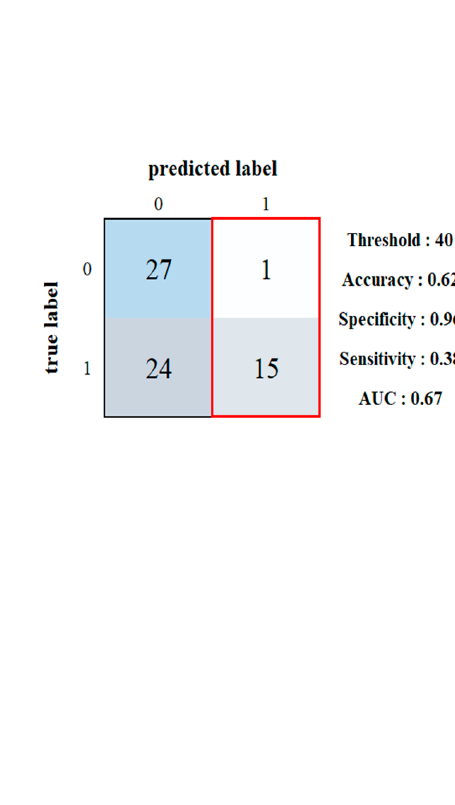
threshold score, the mean accuracy, specificity, sensitivity, and AUC of LDA were 62.68%, 0.96, 0.38, and 0.67, respectively. All but 1 of the 16 subjects with a score >40 experienced cardiovascular side effects. When using 0.4 as the score threshold, the mean accuracy, specificity, sensitivity, and AUC of LDA were 67.16%, 0.60, 0.71, and 0.66, respectively.